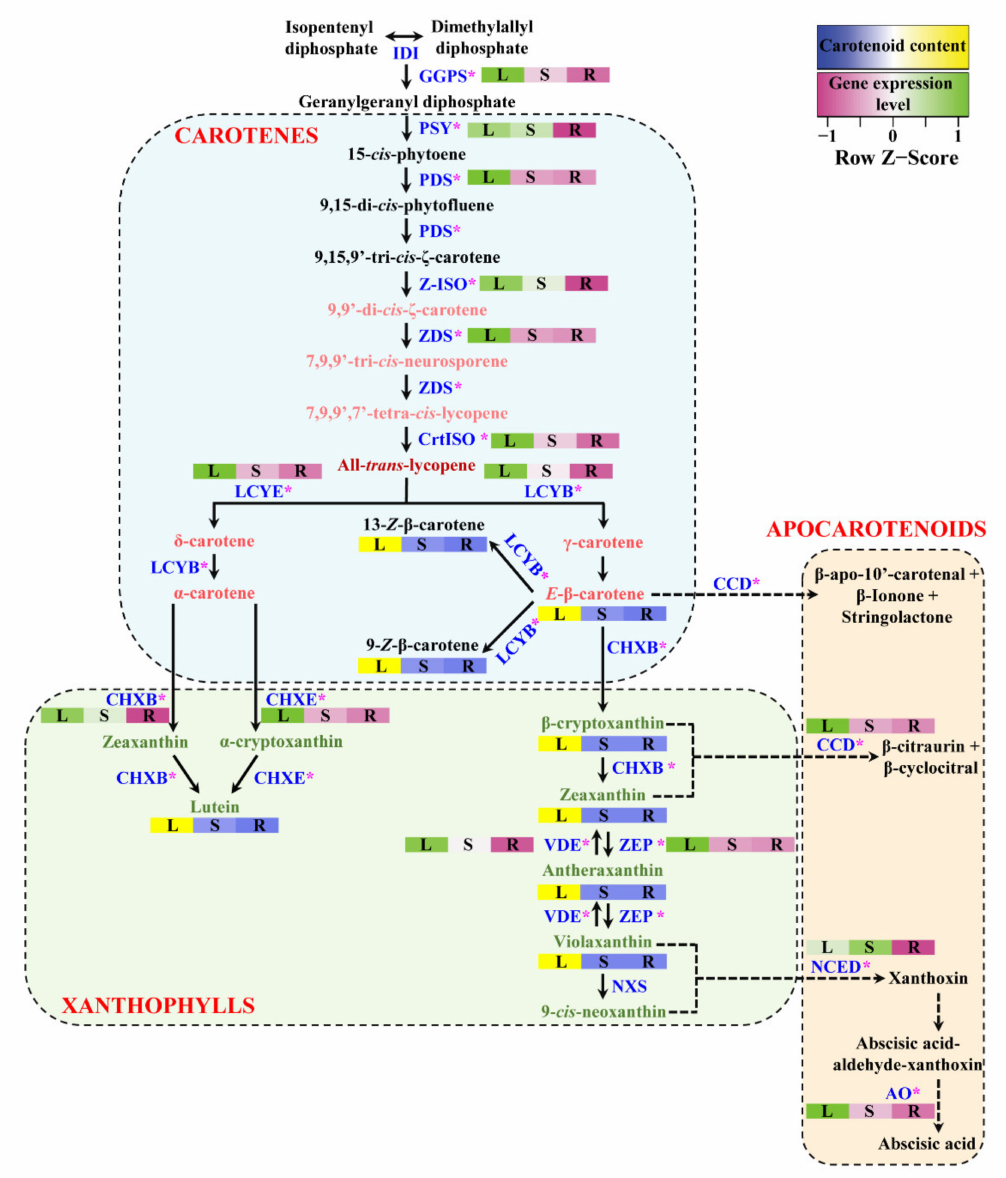
Figure 9. Summary of CP, XP, and AP genes related to carotenoid, xanthophyll, and apocarotenoid biosynthesis in H. moellendorffii . Each different-colored square box denotes the relative gene expression level (pink to green) and carotenoid and xanthophyll accumulation level (blue to yellow) in different organs of H. moellendorffii . The scale bar represents the transformed average value of CP, XP, and AP gene expression levels and metabolites. L—Leaf; S—Stem; R—Root. Asterisks represent the gene used for gene